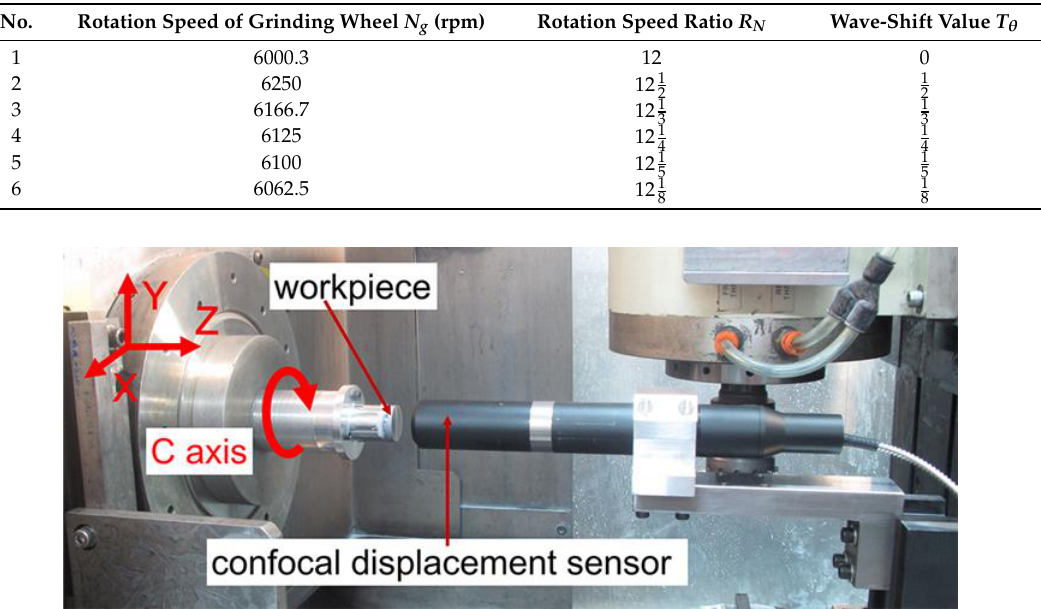
Figure 10. The on-machine measurement devices of the circular waviness profile of the Fresnel micro-structured mold. Table 2. Experiment parameters design.